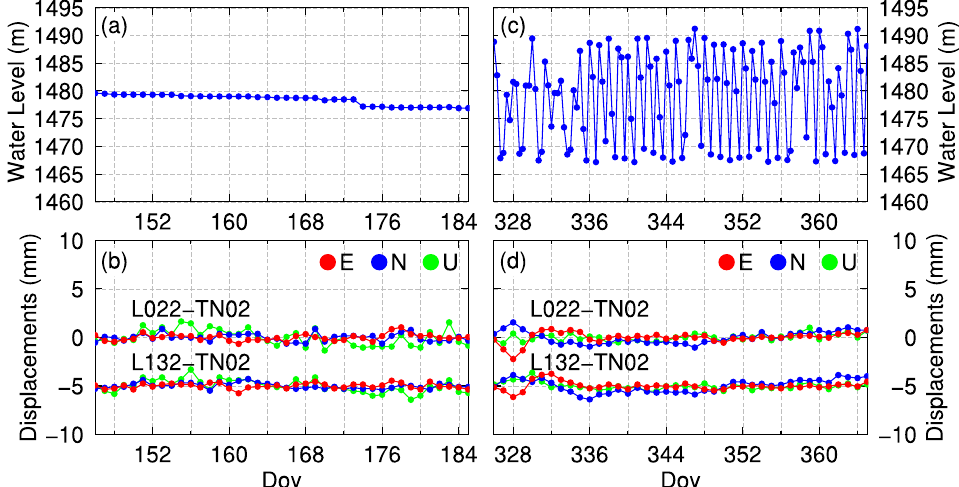
Figure 10. Water levels ( a , c ) and baseline time series ( b , d ) comparison during quiet and active periods. The baseline time series of L132–TN02 are moved downward to −5 mm for clarity.